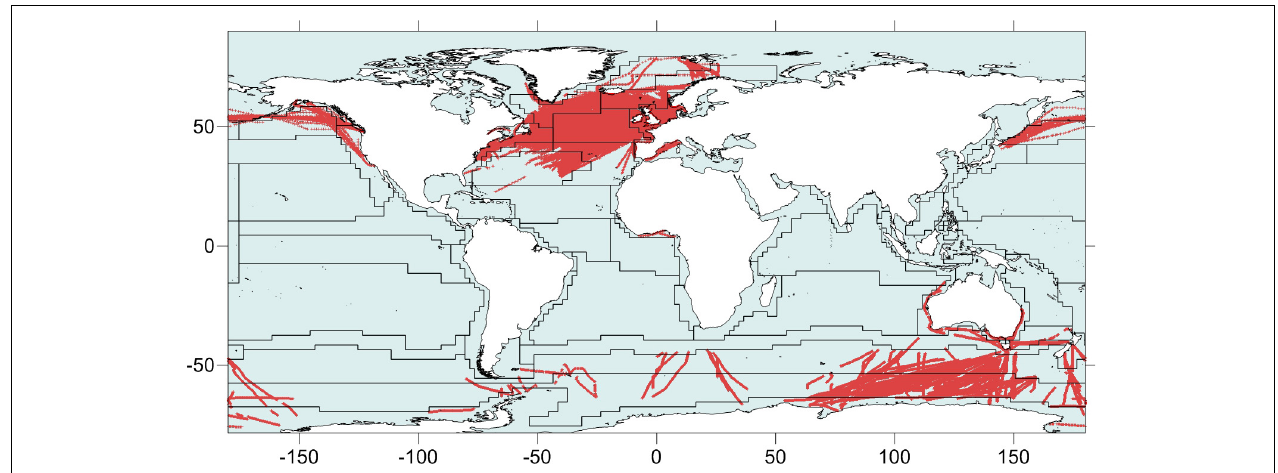
FIGURE 3 | Longhurst Provinces (Flanders Marine Institute, 2009) overlaying CPR sample locations (red). Names of provinces are not shown to avoid clutter but can be found at http://www.marineregions.org/images/boundaries/Longhurst_crop.png.